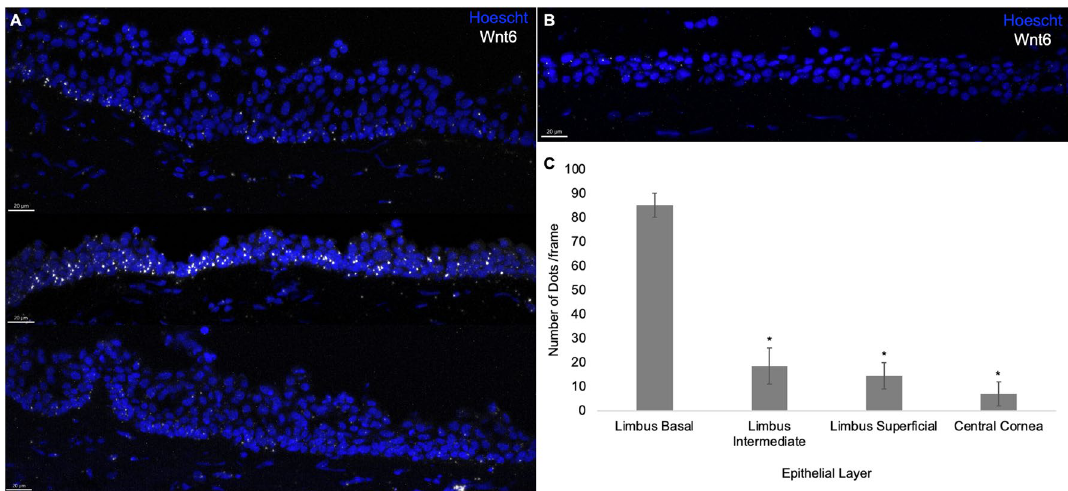
Figure 2. RNAscope fluorescence in situ hybridization assay. RNAscope assay showing high expression of Wnt6 mRNA in the human limbus. ( A ) Wnt6 mRNA expression in the limbus. ( B ) Wnt6 mRNA expression in the central cornea. ( C ) Wnt6 mRNA was preferentially expressed at the basal limbal epithelial layer compared with the intermediate and superficial limbal layers and with the central cornea (all P < 0.05 in comparison with the basal limbal epithelial layer). Data are means ± SEM of 2 independent